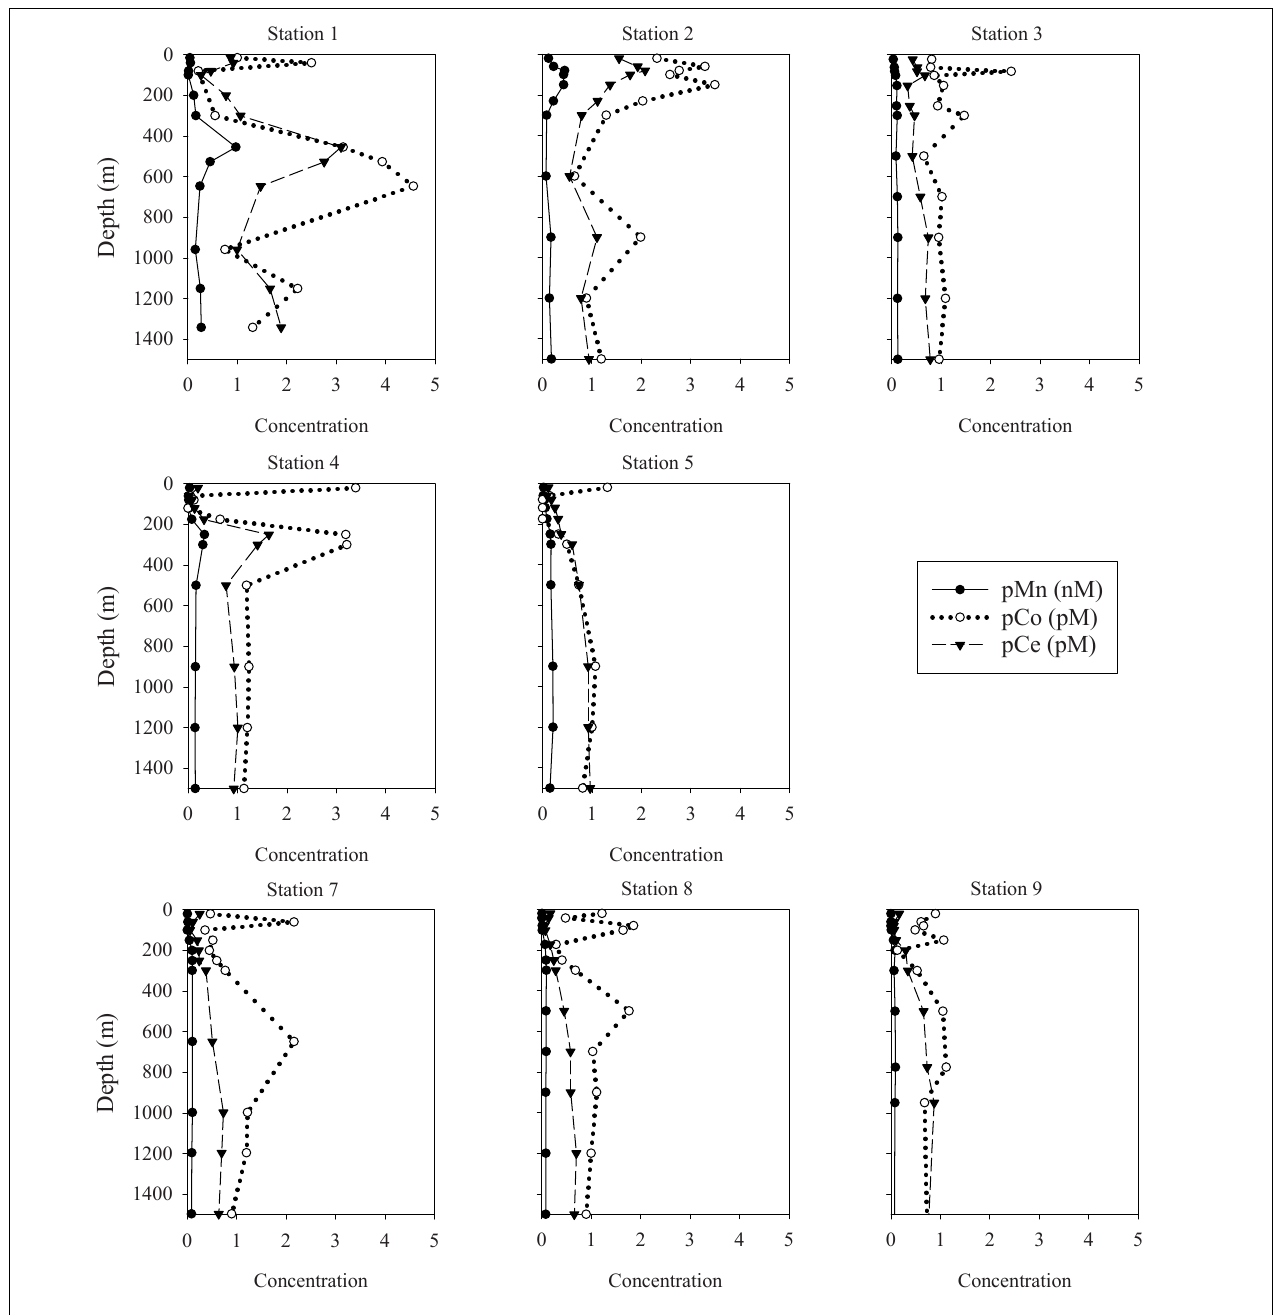
FIGURE 7 | Vertical properties of particulate trace elements: Vertical profiles of particulate Mn (nM), Co (pM), and Ce (pM).